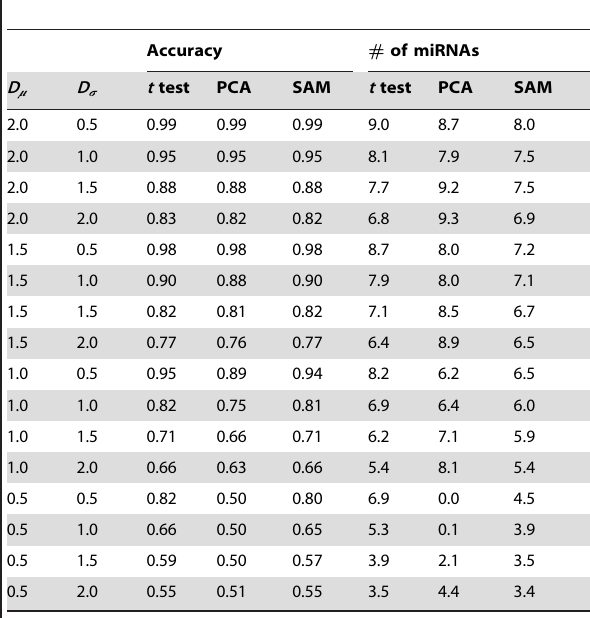
Table 1. Performance of several feature extraction methods for scenario